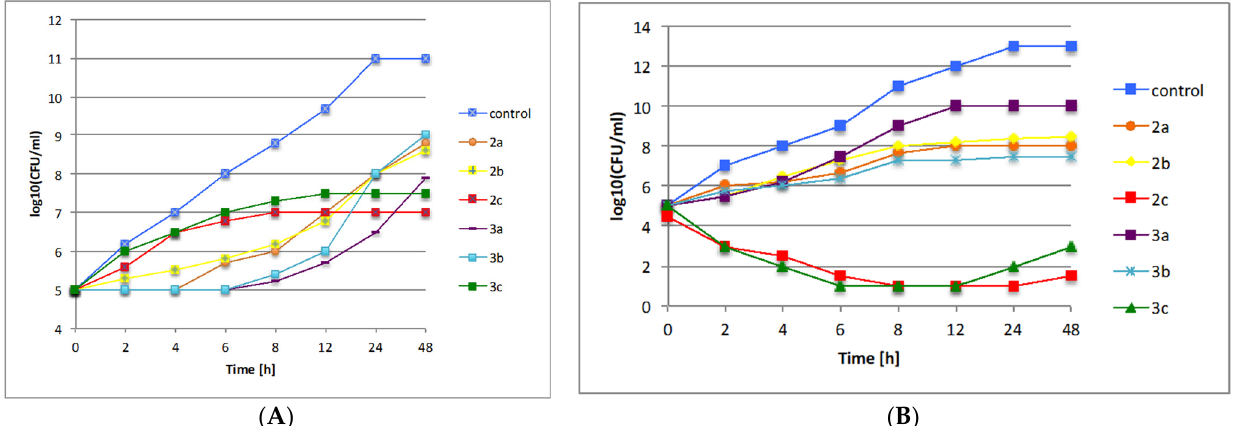
Figure 1. Time-kill kinetics of compounds 2a , 2b , 2c , 3a , 3b , 3c against S. aureus ATCC 29213 ( A ) and S. epidermidis ATCC 12228 ( B ). Samples were analyzed by plating and counting of colony-forming units (CFUs) at 0, 2, 4, 6, 8, 12, 24, 48 h. The blue line represents control culture grown in the absence of tested compounds, while orange, yellow, red, violet, turquoise and green lines represent cultures treated with tested compounds.